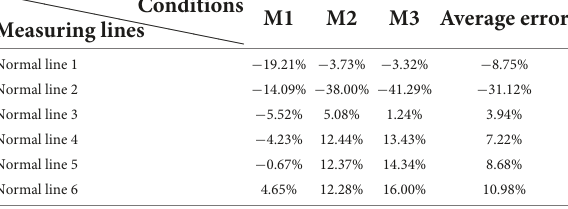
TABLE 3 Comparison of errors in applying two different normal lines to calculate flow rates. (cid:96)(cid:96)(cid:96)(cid:96)(cid:96)(cid:96)(cid:96)(cid:96)(cid:96)(cid:96) linesConditions M1 Measuring